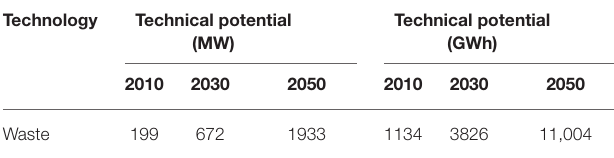
TABLE 7 | The potential of Municipal Solid Waste (MSW) in Pakistan (Farooq and Kumar, 2013; Valasai et al., 2017).